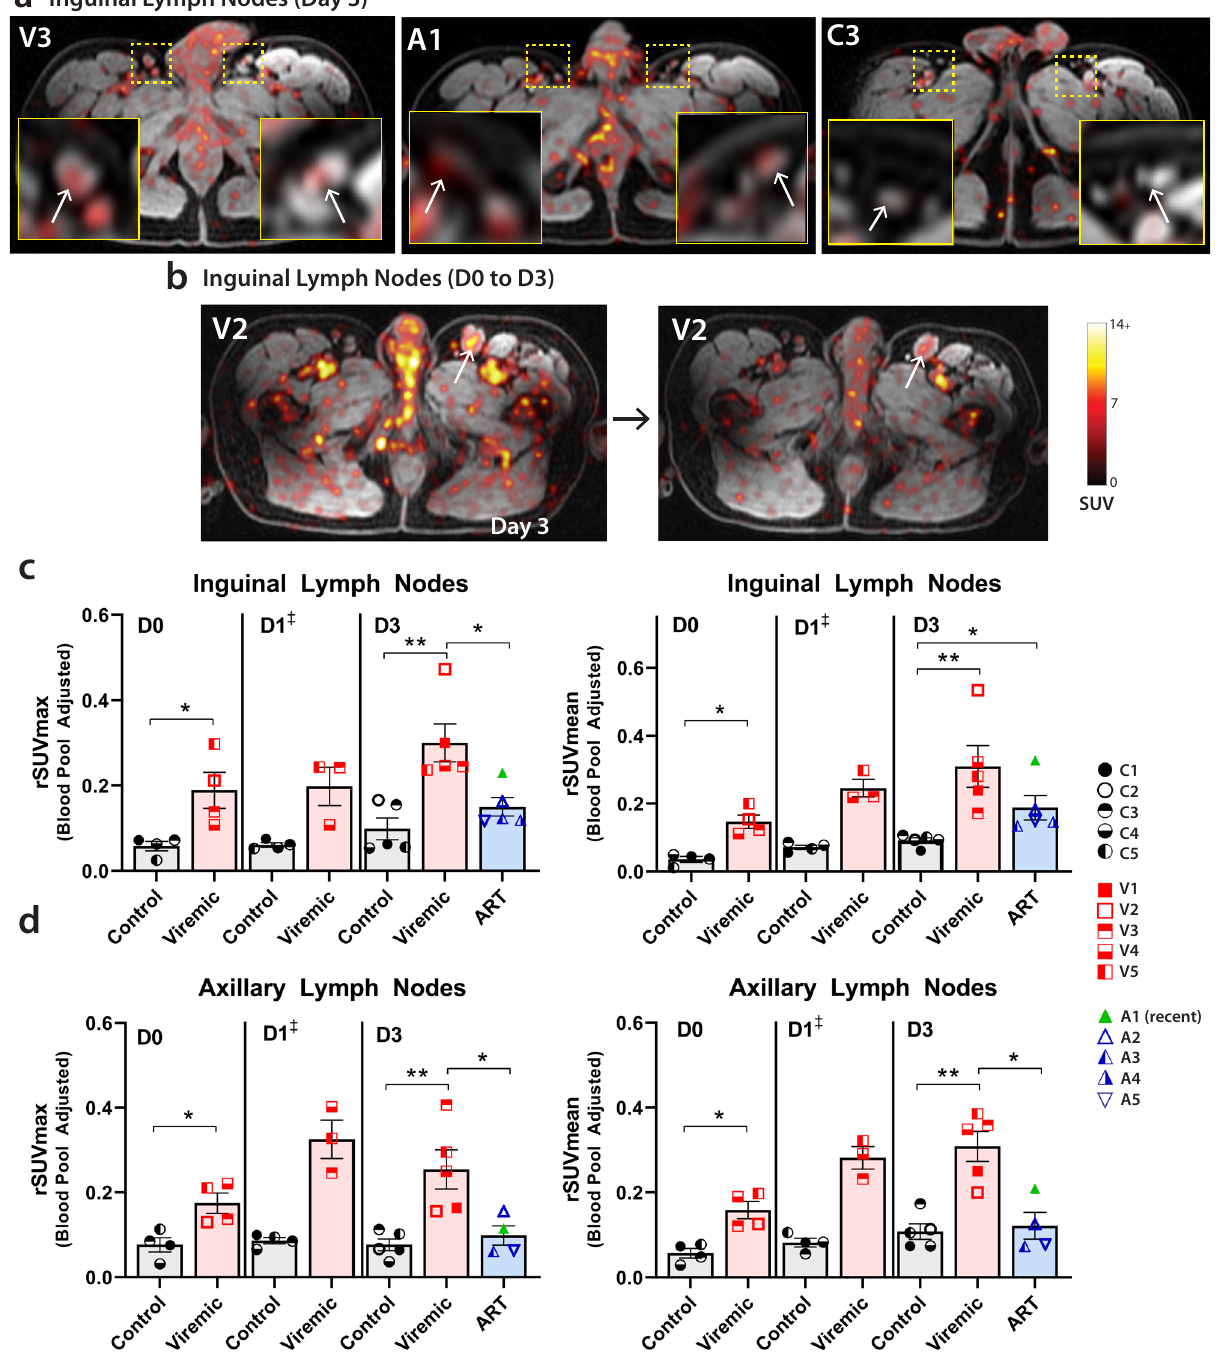
Fig. 2 89 Zr-VRC01 uptake is preferentially increased in participants with HIV compared with uninfected controls. a Representative axial PET-MR images with inset magni fi cation of bilateral inguinal lymph nodes on imaging day 3 for a viremic (V), ART-suppressed (A) and uninfected control (C). b Axial image of persistent inguinal lymph node 89 Zr-VRC01 uptake in inguinal lymph nodes on imaging day 0 (6 h post injection), and imaging day 3 (72 h post injection) ( b ). rSUVmax and rSUV mean values for c inguinal and d axillary lymph node uptake averaged across bilateral nodes at imaging day 0, day 1, and day 3. Participant A1 (green triangle) started ART approximately 3 months prior PET imaging (early treatment initiation). ART suppressed participants were imaged starting on day 3 as per study protocol. SUV standardized uptake value, rSUV blood pool-adjusted 89 Zr-VRC01 standardized uptake value (tissue to blood pool SUV ratio); P values <0.05 and <0.01 represented by * and **, respectively from two-sided non-parametric analyses (Mann – Whitney tests for analyses involving two groups and Kruskal – Wallis tests for analyses involving three groups). Mean and standard error bars are shown. Control N = 4 on day 0 and day 1, viremic case N = 4 and 3 on day 0 and day 1, respectively ( ‡ statistical analyses not performed on day 1 as one viremic participant missed this visit). Control and viremic and ART case N = 5 on day 3. Source data are provided as a Source Data fi